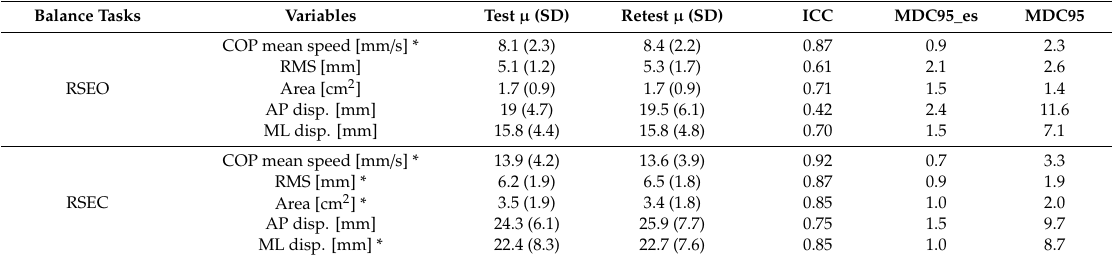
Table 2. Test-retest results from balance tests. Minimal detectable changes